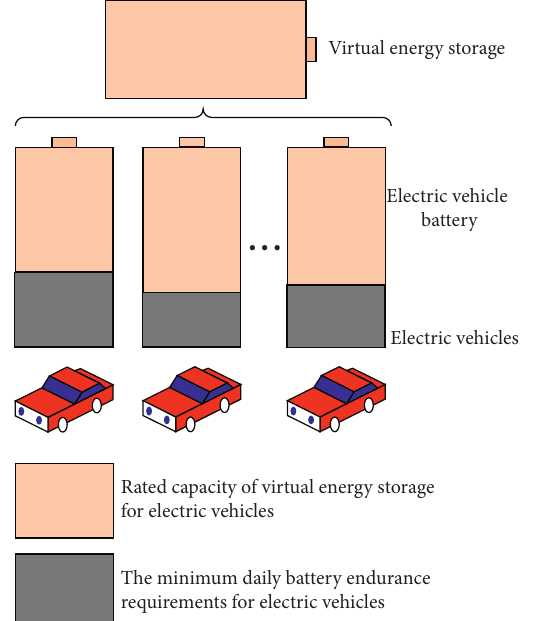
Figure 3: Schematic diagram of the virtual energy storage process of electric